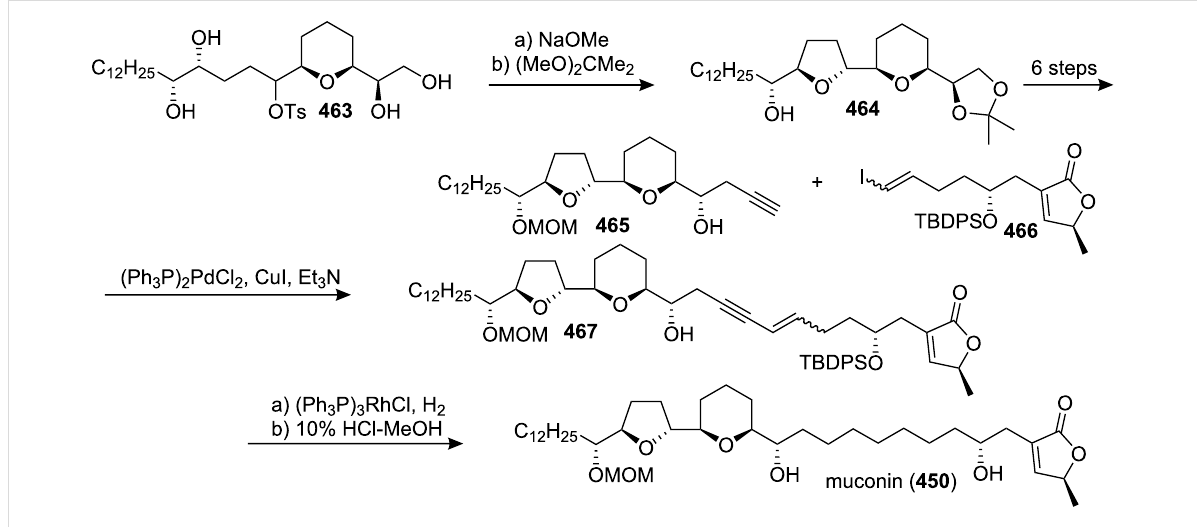
Scheme 66: Total synthesis of muconin by Takahashi’s